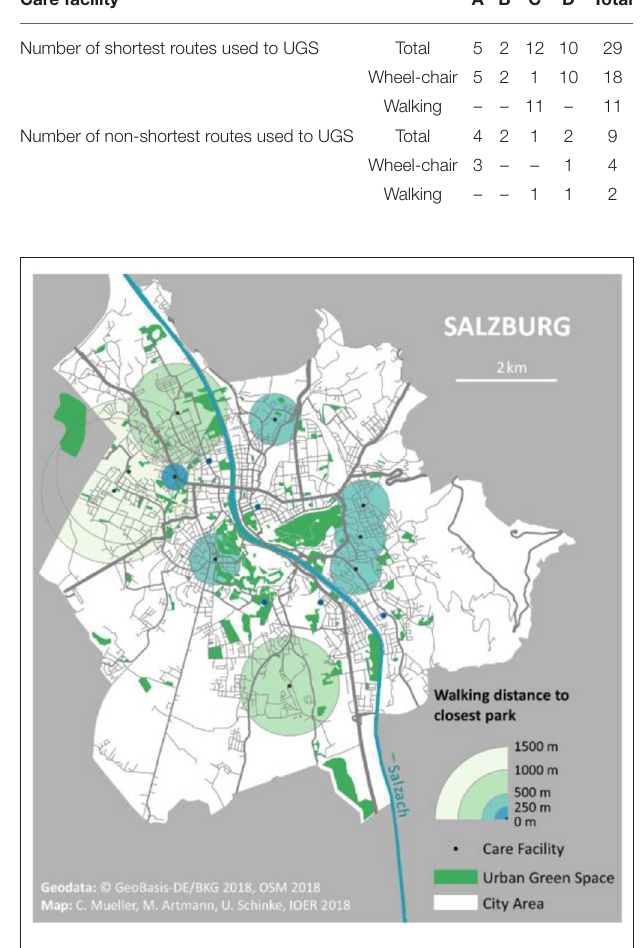
FIGURE 4 | Accessibility of urban parks for care facilities for the elderly in